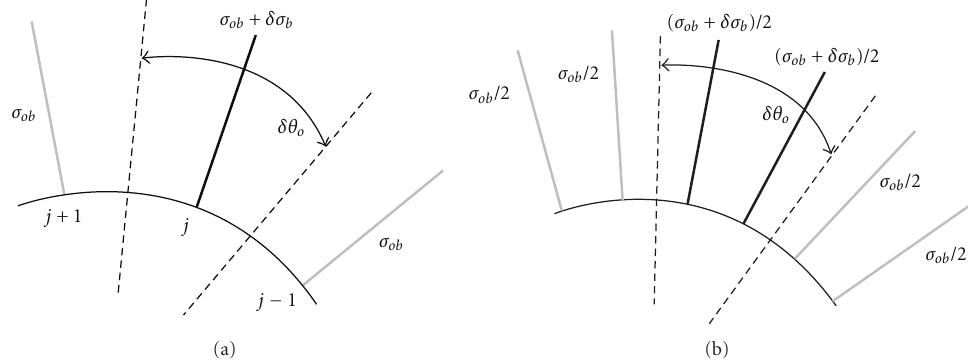
Figure 2: Homogenization limit for an imperfect rotor; imperfection due to an increase of linear mass density of a blade. (a) Reference rotor with N b blades and imperfection on the j th blade, in black color. (b) Homogenization step process k = 1; rotor with N = 2 N b blades, with rescaled bending sti ff ness and linear mass density.